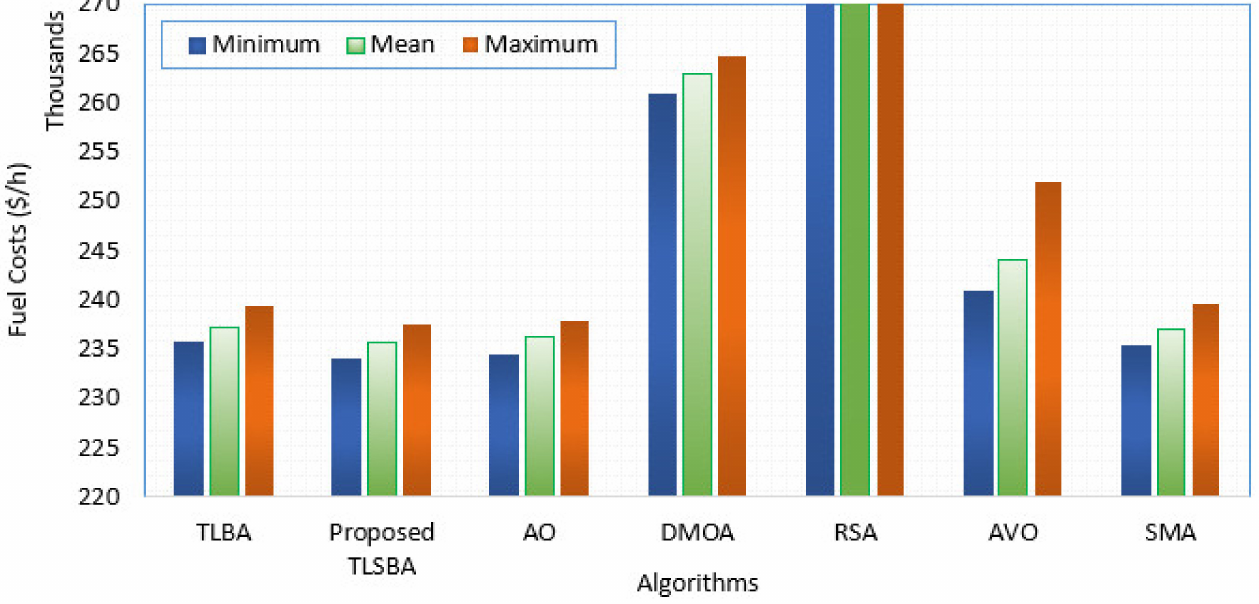
Figure 15. Minimum, mean and maximum obtained fitness by the compared techniques for test system 3.